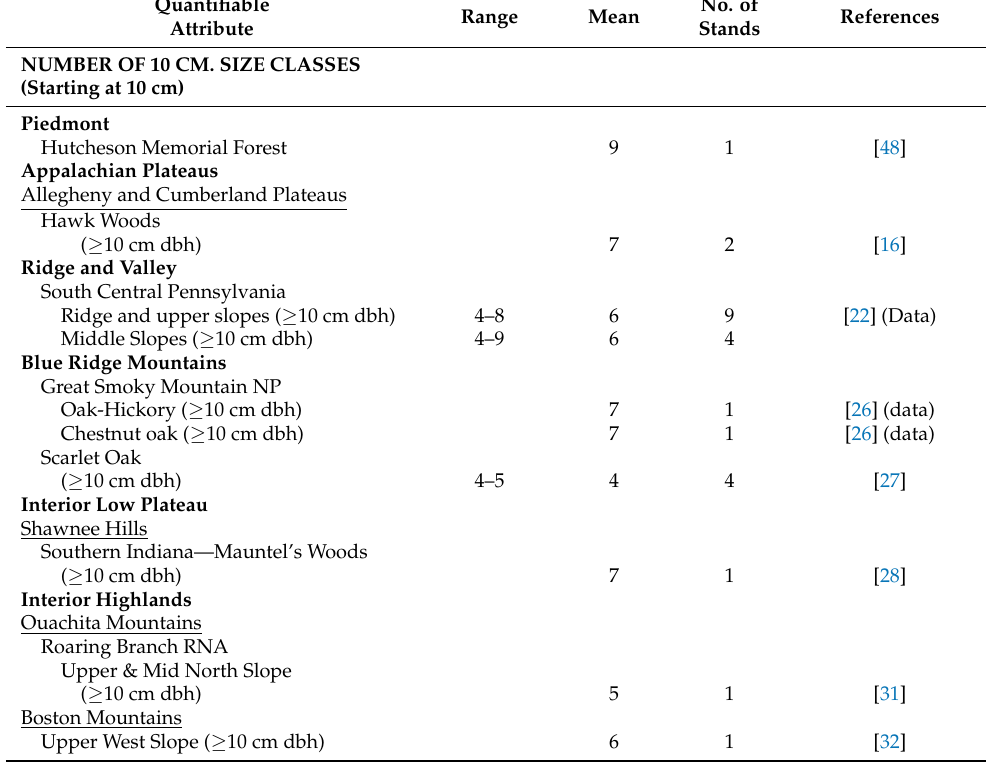
Table 5. Number of 10 cm size classes of representative dry-mesic old-growth oak